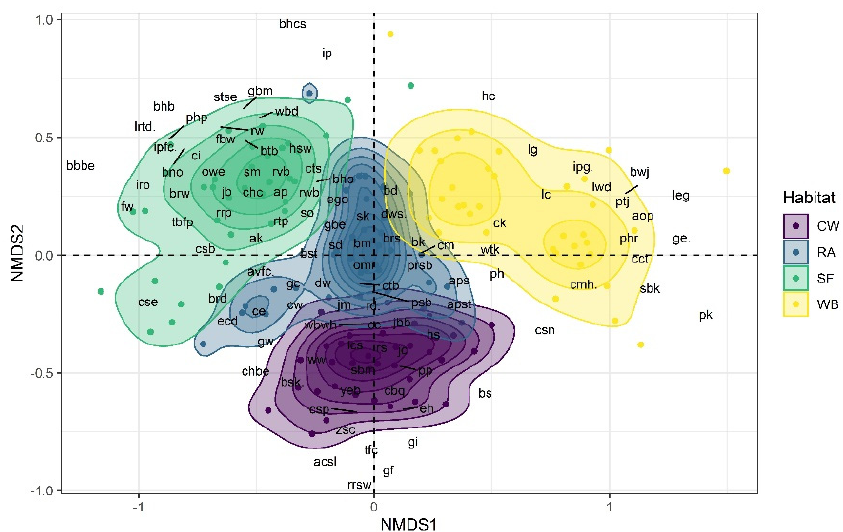
Figure 4. Non-metric Multidimensional Scaling (NMDS) showing the different bird species compo- sition at each habitat (stress = 0.25; Non-metric fit R 2 = 0.936; linear fit R 2 = 0.695); CL =